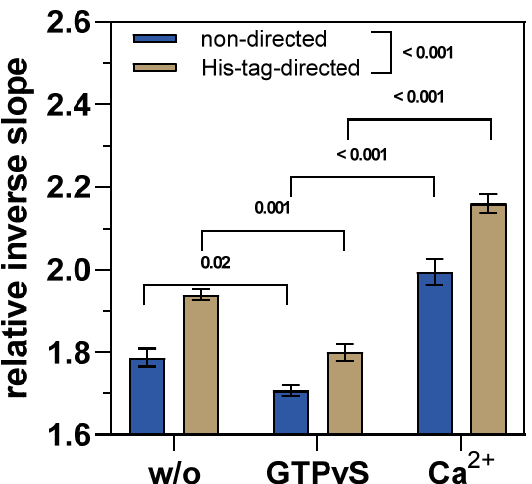
Figure 4. Changes of the hTGase 2-dsDNA lever motion as response to GTP γ S (20 nM) and Ca 2+ (1 mM) in dynamic mode for non-directed and His-tag-directed labeling of hTGase 2. The DNA lever motion was analyzed based on the inverse slope at the inflection point of the time-dependent fluorescence trace. The obtained values were divided by the inverse slope of the bare dsDNA. A higher relative inverse slope indicates higher friction of the hTGase 2-dsDNA lever. Shown are mean values (4 electrodes of one experiment) ± standard deviation. For statistical comparison of the relative inverse slopes within one labeling strategy and for a comparison of the labeling strategies in general, the values were subjected to a two-way repeated measures ANOVA with Tukey’s multiple comparison test (matched values for the relative inverse slopes obtained for the same electrode). p values are given above the brackets and values <0.05 were considered statistically significant. Although not shown, the relative inverse slopes for “w/o” and “Ca 2+ ” are also significantly different with p = 0.008 (non-directed labeling) and p < 0.001 (His-tag-directed